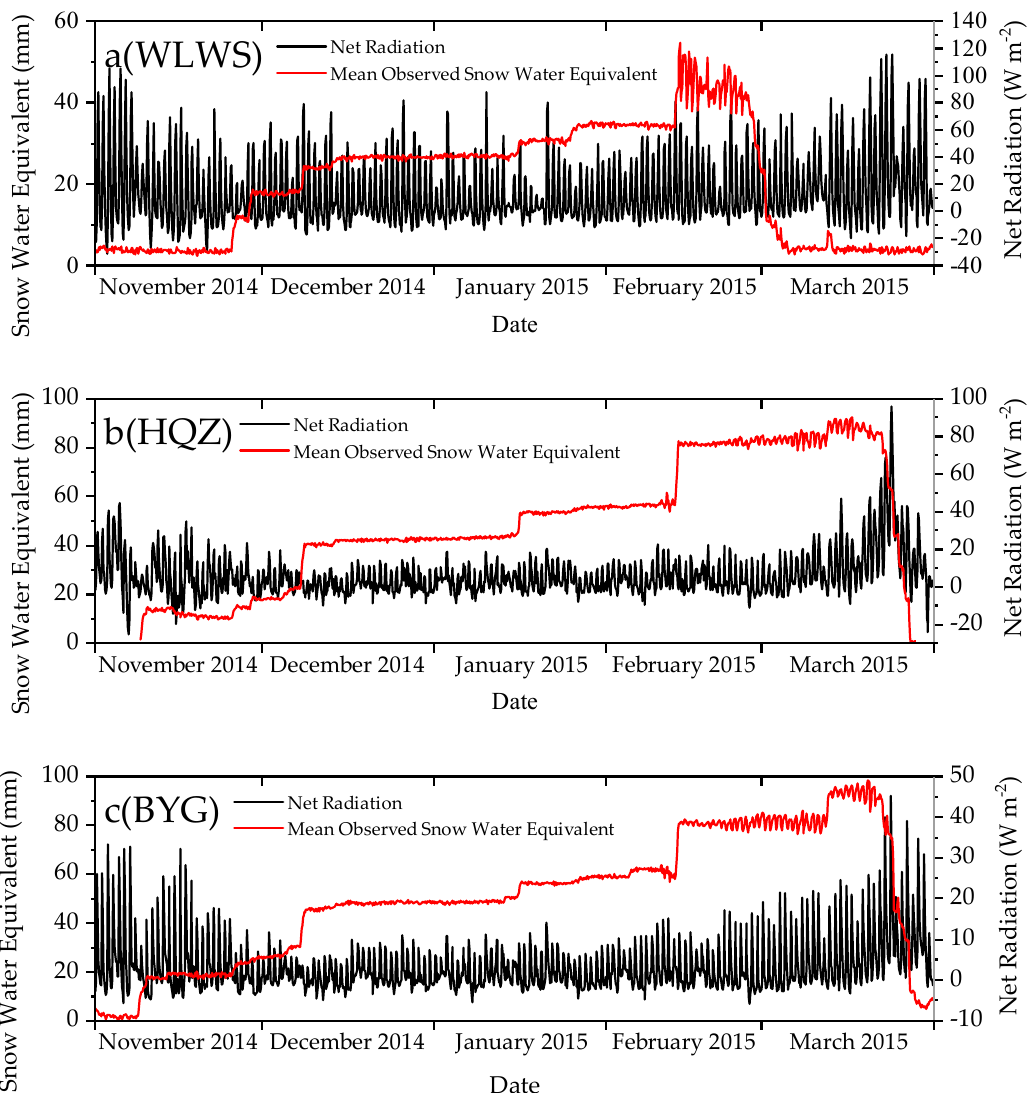
Figure 6. Variation characteristics of the simulated net radiation and measured SWE at 3-h intervals between 0:00 on 1 November 2014 and 21:00 on 31 March 2015.